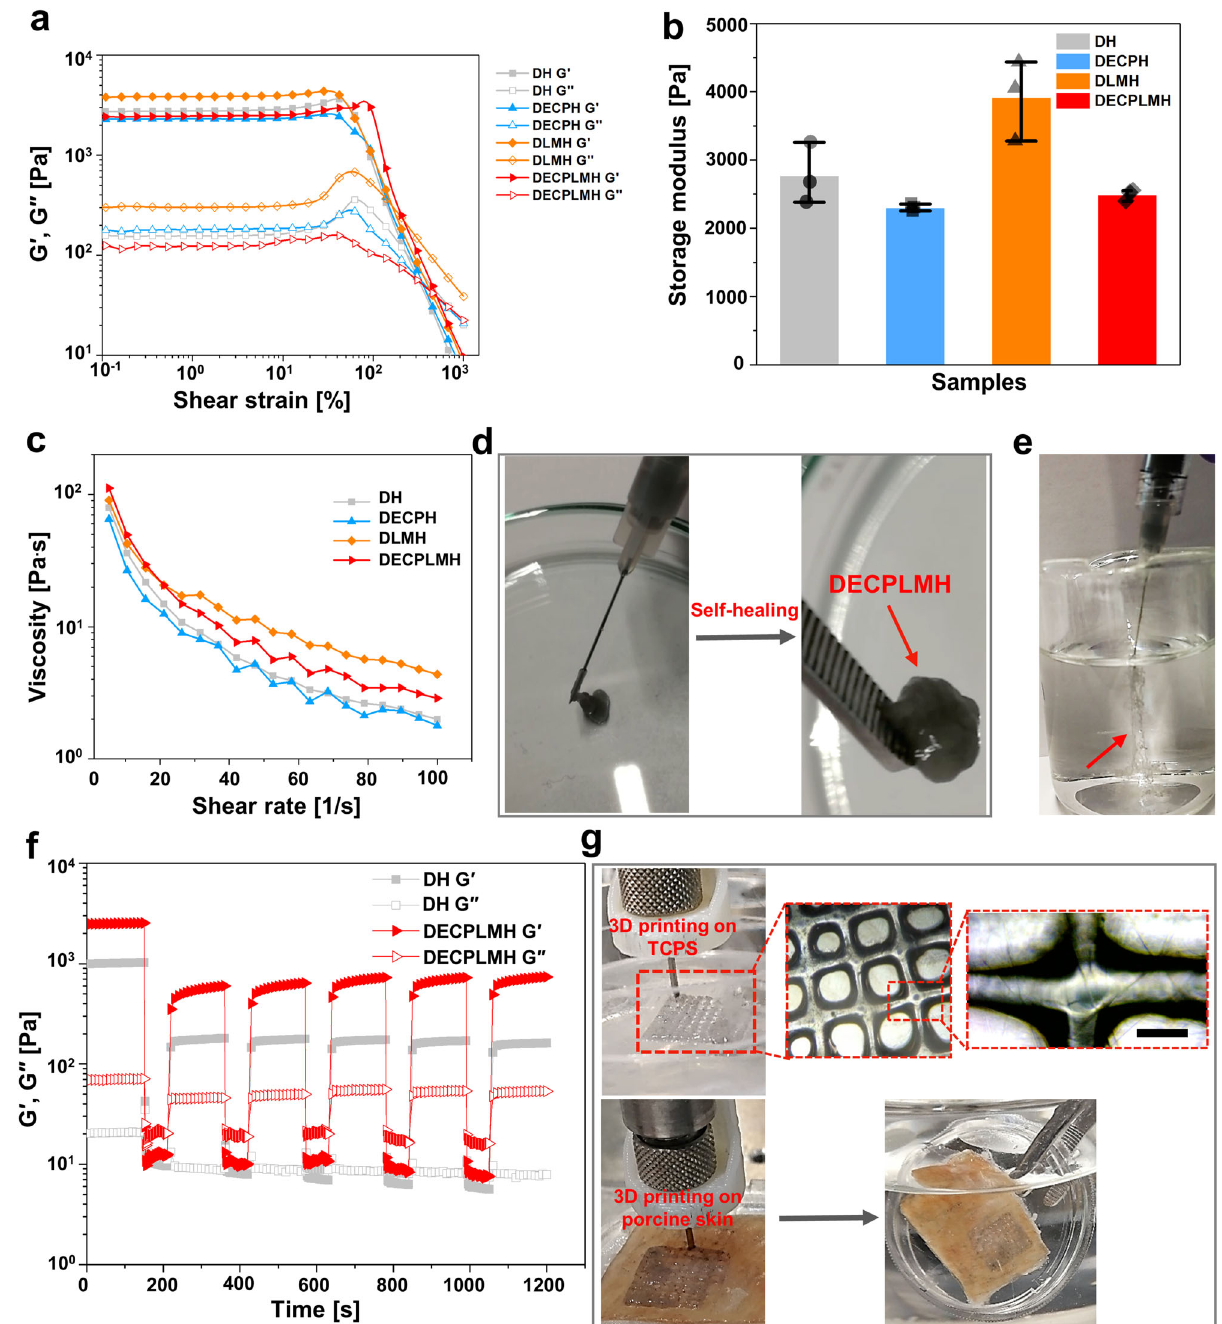
Fig. 4 Rheological properties of the electroconductive hydrogels. a Amplitude sweep performed with the shear strain increasing from 0.1% to 1000%. b The storage modulus of hydrogels at 10% shear strain ( n = 3 hydrogel samples, mean ± SD). c Continuous fl ow experiments showing the viscosity of the hydrogels plotted against the shear rate. d Injection of a hydrogel via a syringe with 27G needle onto a plastic plate. The injected dynamic electroconductive biopolymer/liquid metal hydrogels (DECPLMH) maintain their structural integrity when gripped and sticks to the tweezer (indicated by the arrows). e The DECPLMH was syringe-injectable and thin fi laments (indicated by the arrows) were extruded into PBS solution. f Self-healing property of the hydrogels when the alternate step strain was switched from 1 to 1000%, indicated by the recoverage of the elastic modulus. g 3D printing of a DECPLMH, which can adhere to the TCPS (tissue culture plastic surface) (upper panel), and the magni fi cation of the printed fi ber overlapping area. Scale bar = 200 µ m. A representative image of three individual samples is shown. 3D printing in situ on porcine skin (the bottom panel), and remaining stable when holding the dish vertically in the 0.01 M PBS